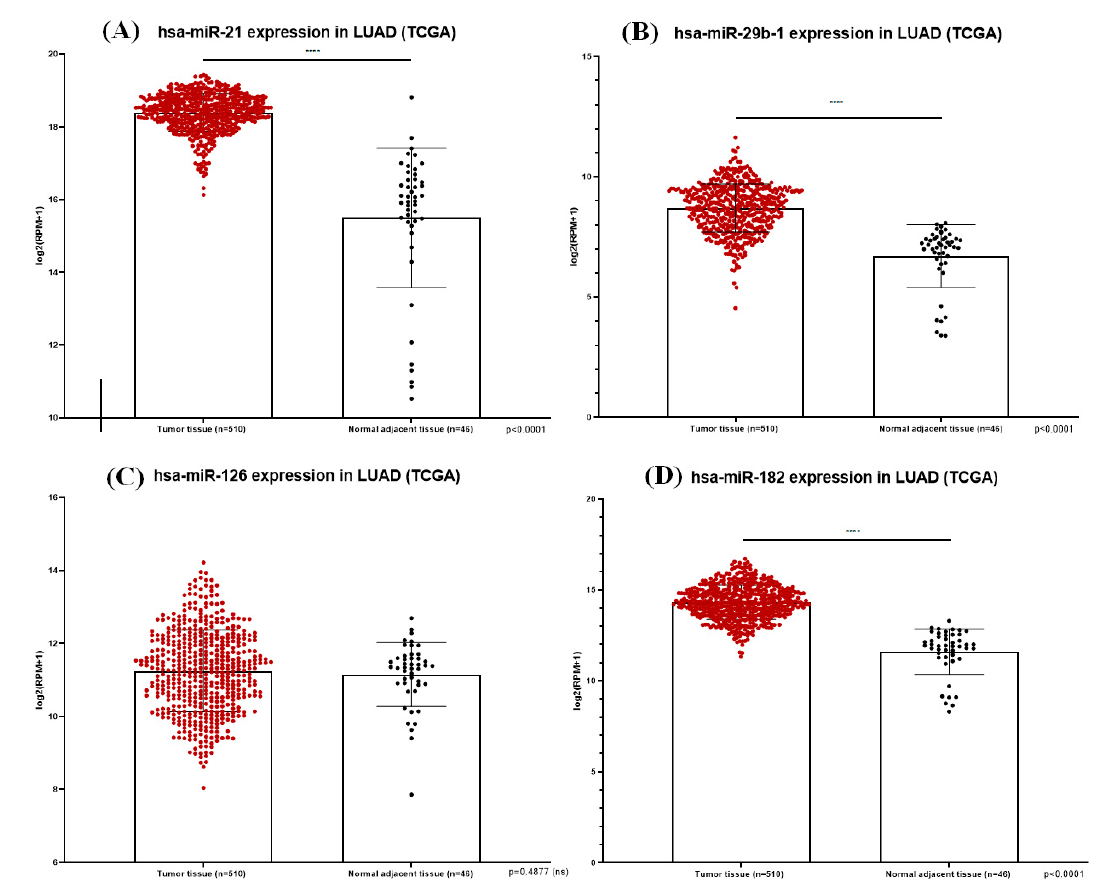
Figure 3. MiR-21 ( A ), miR-29b-1 ( B ), miR-126 ( C ) and miR-182 ( D ) expression in LUAD tissue samples from TCGA database; the plots show statistically significant overexpression of miR-21, miR-29b-1 and miR-182 with p < 0.0001